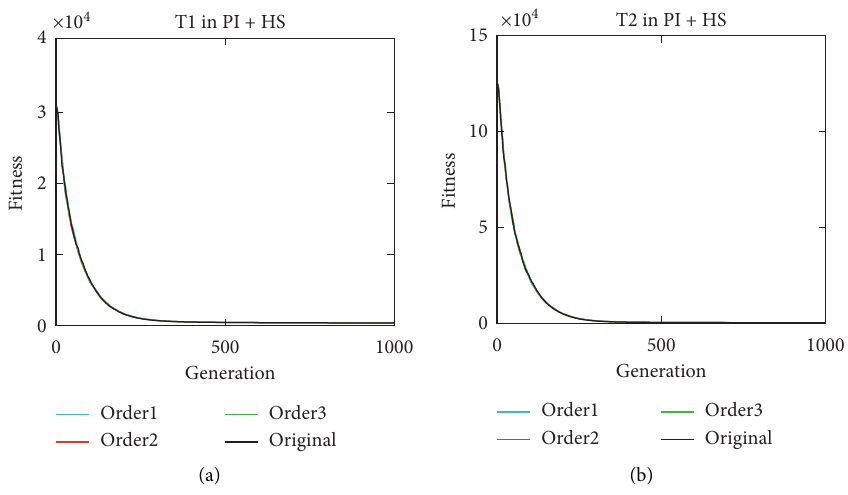
Figure 16: Convergence of MFDE for problem 4 (PI+ HS).